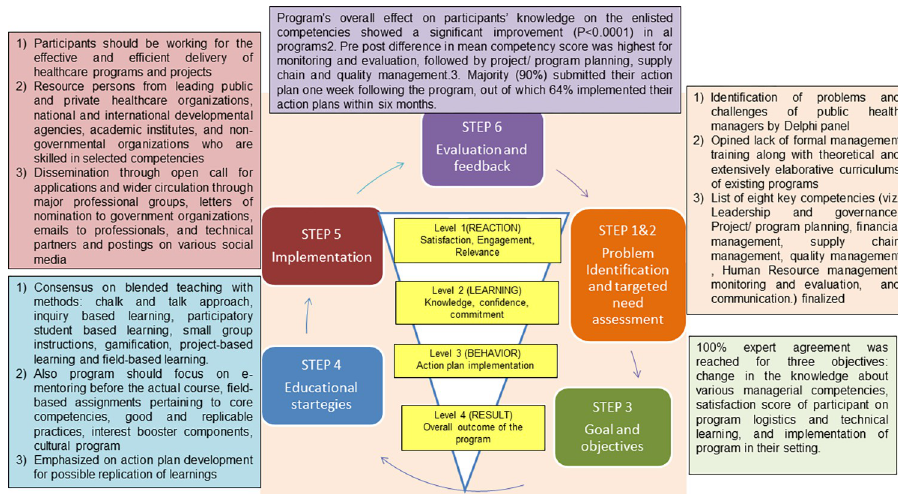
Fig 1. Conceptual framework for development and evaluation of International Public Health Management Development Program using Kern and Kirkpatrick framework.